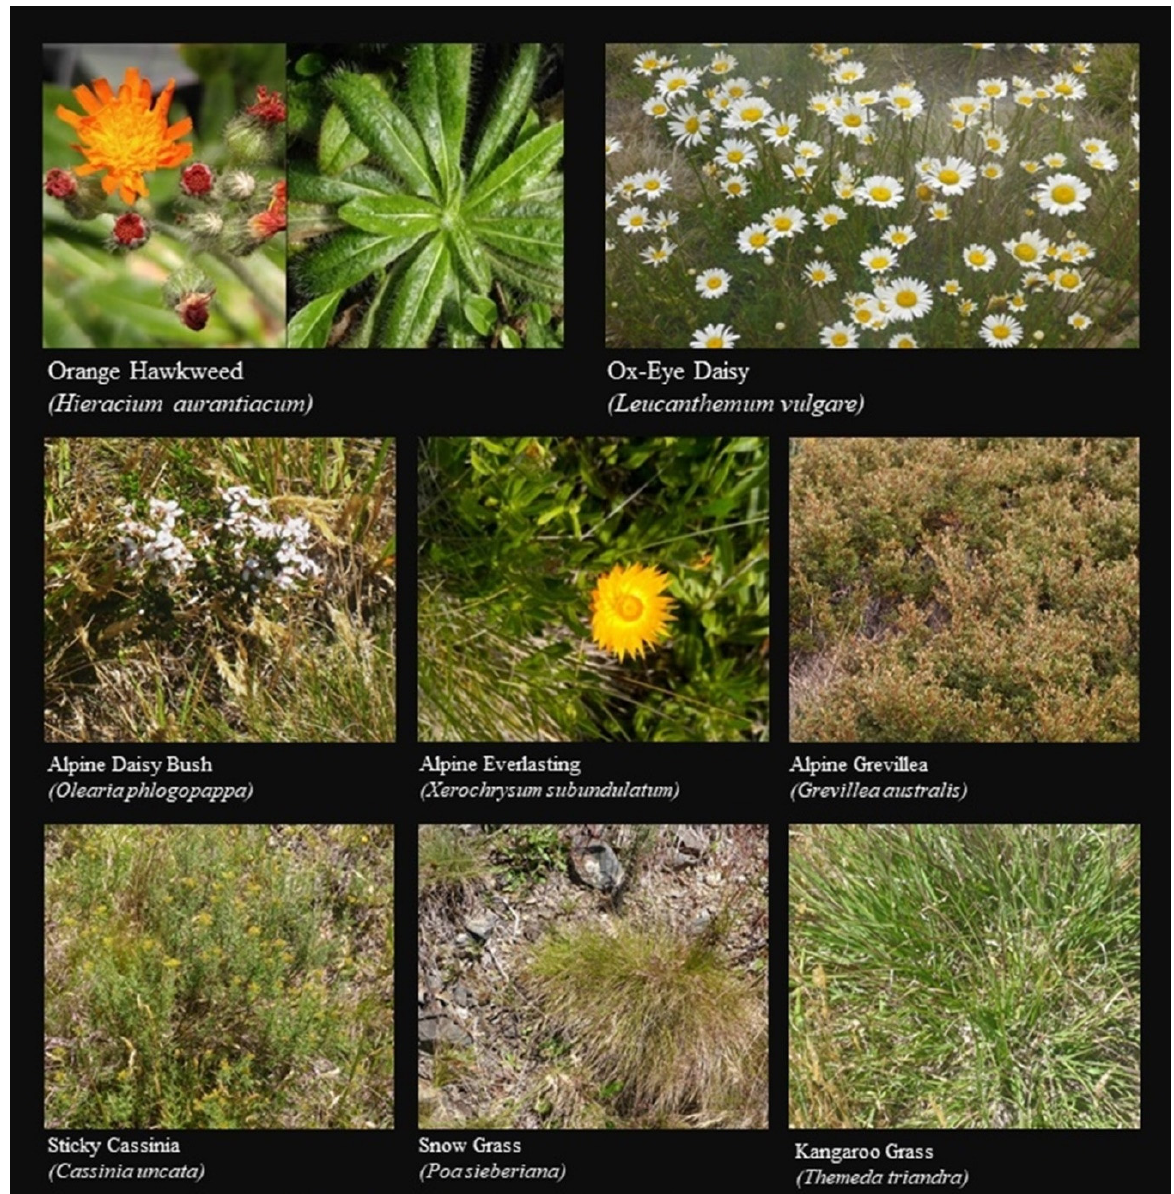
Figure 3. Examples of species selected for spectral sampling. Orange Hawkweed and Ox-eye Daisy are the targeted invasive weeds.